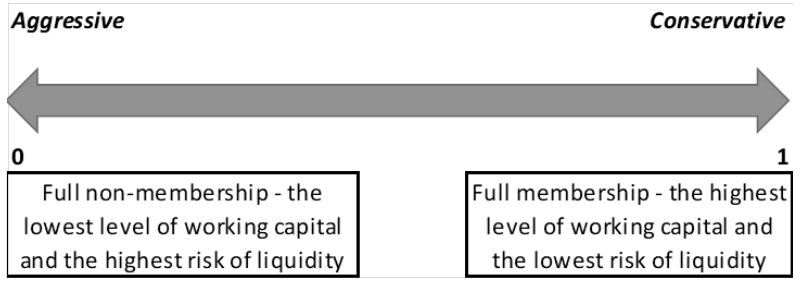
Fig. 1. A fuzzy logic approach to the strategy for working capital